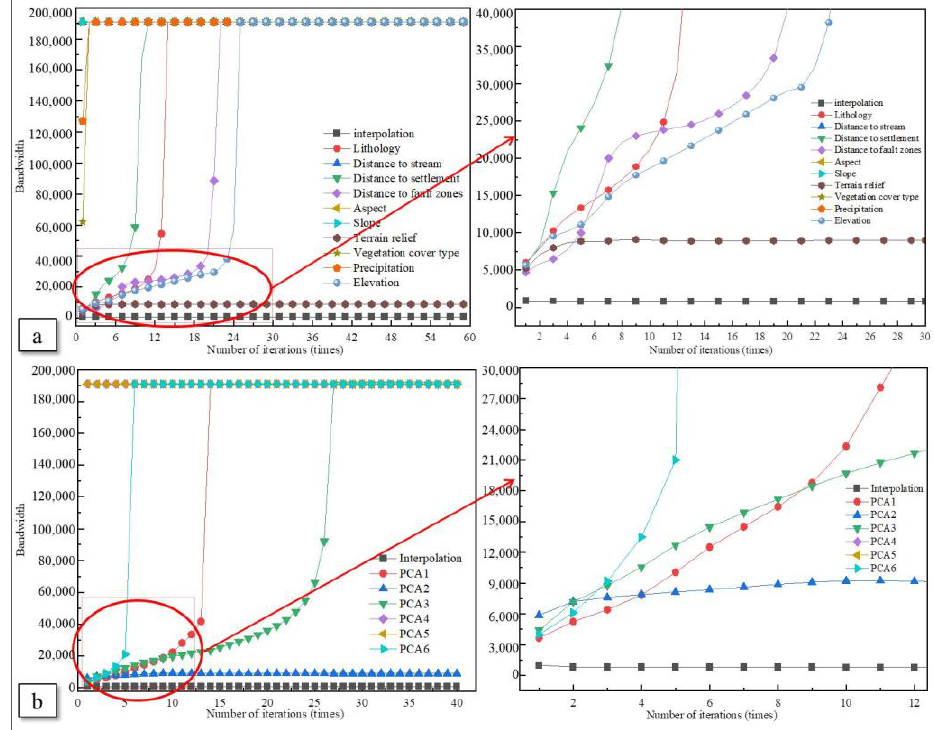
Figure 11. Iterative process of bandwidths based on the back-fitting algorithm: ( a ) LCFs for MGWR, ( b ) PCs for PCAMGWR.